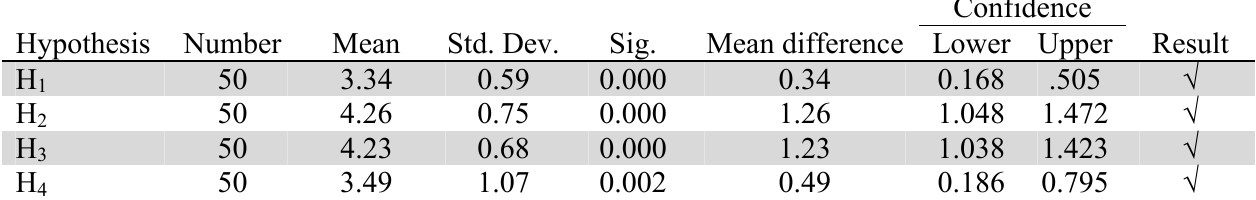
The summary of some basic statistics and testing firm’s characteristics